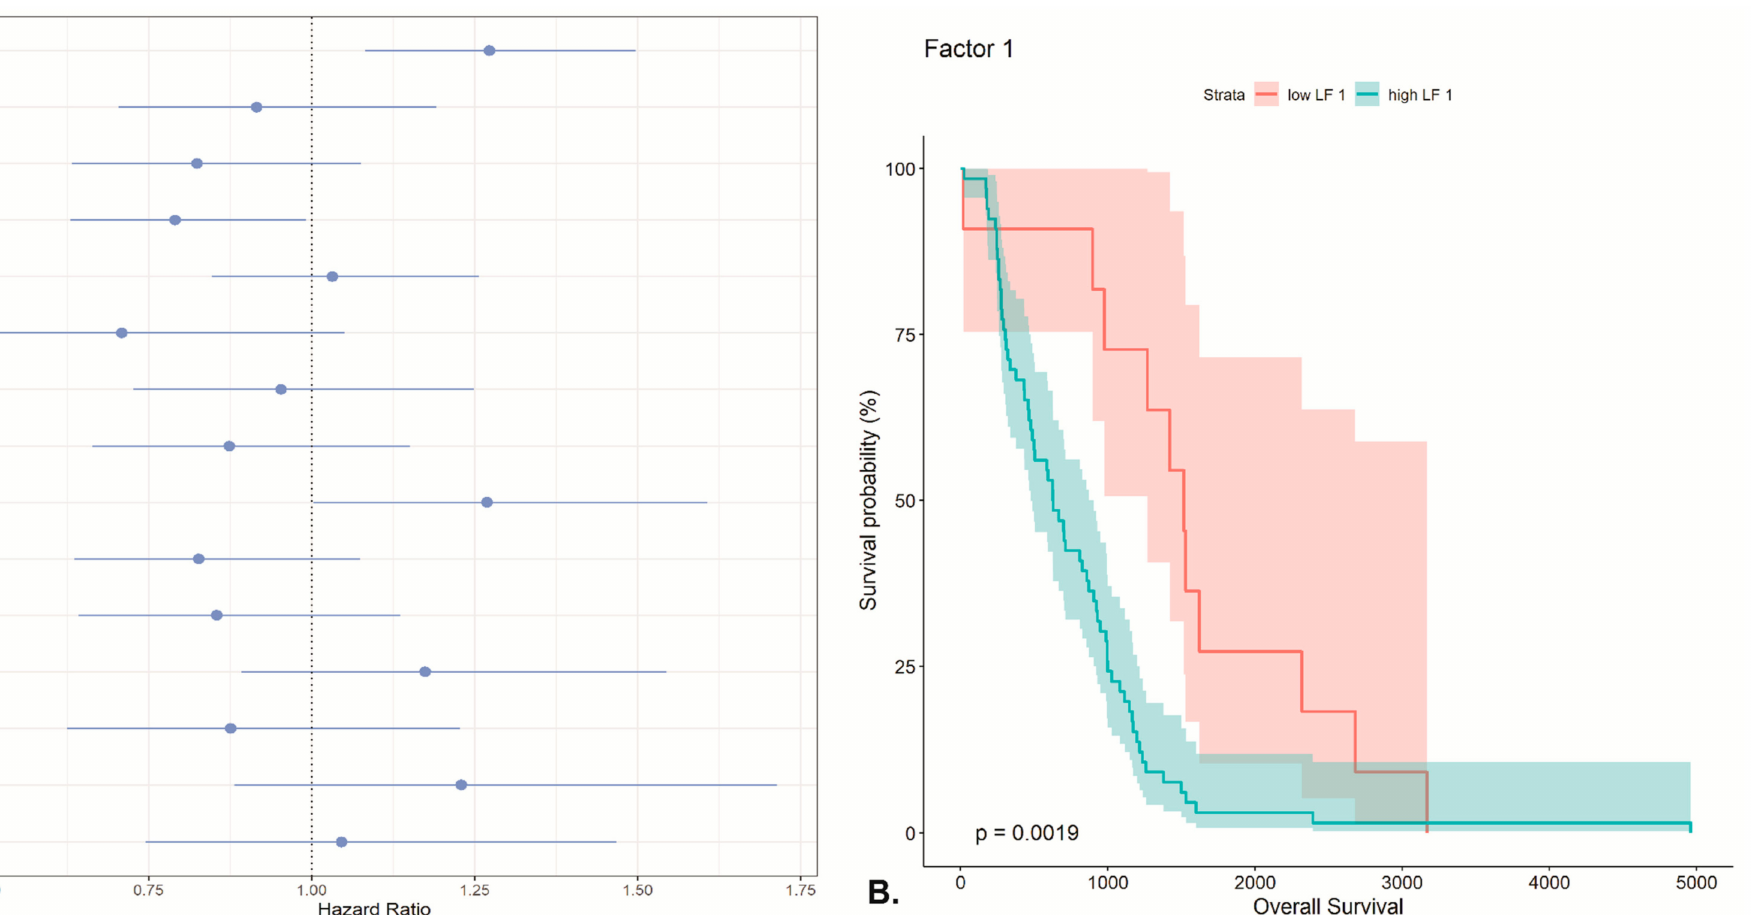
Figure 5. Putative prognostic utility of the Multi-Omics Factor Analysis (MOFA) latent factors. ( A ). Forest plot of resulting hazard ratios, illustrating the association of the tested MOFA factors with overall survival, based on Cox regression modeling (error bars representing 95% confidence intervals) ( B ) Example of a Kaplan-Meier plot for Factor 1, showing overall survival. The samples were separated into two distinct groups, based on the maximally selected rank statistics from the maxstat R package [175]. As Factor 1 has a positive coefficient, samples with high values have an increased hazard in comparison to samples with low relative values. The p -value was calculated using a log-rank test on the two aforementioned